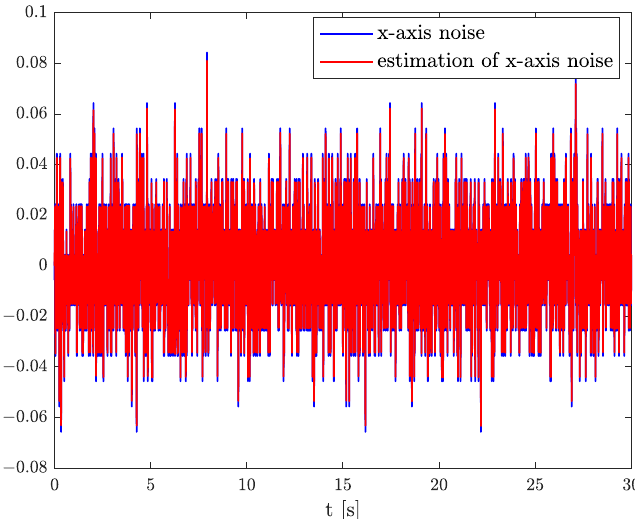
Figure 12. Original and estimation of x -axis